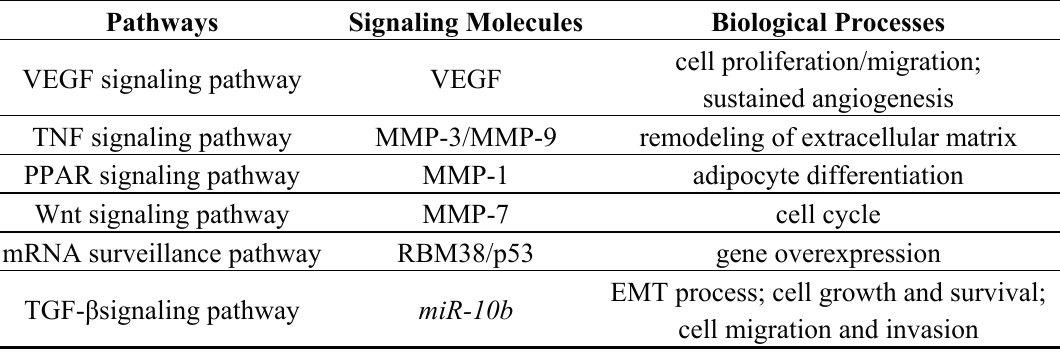
Table 6. HOTAIR -related signaling pathways/processes in